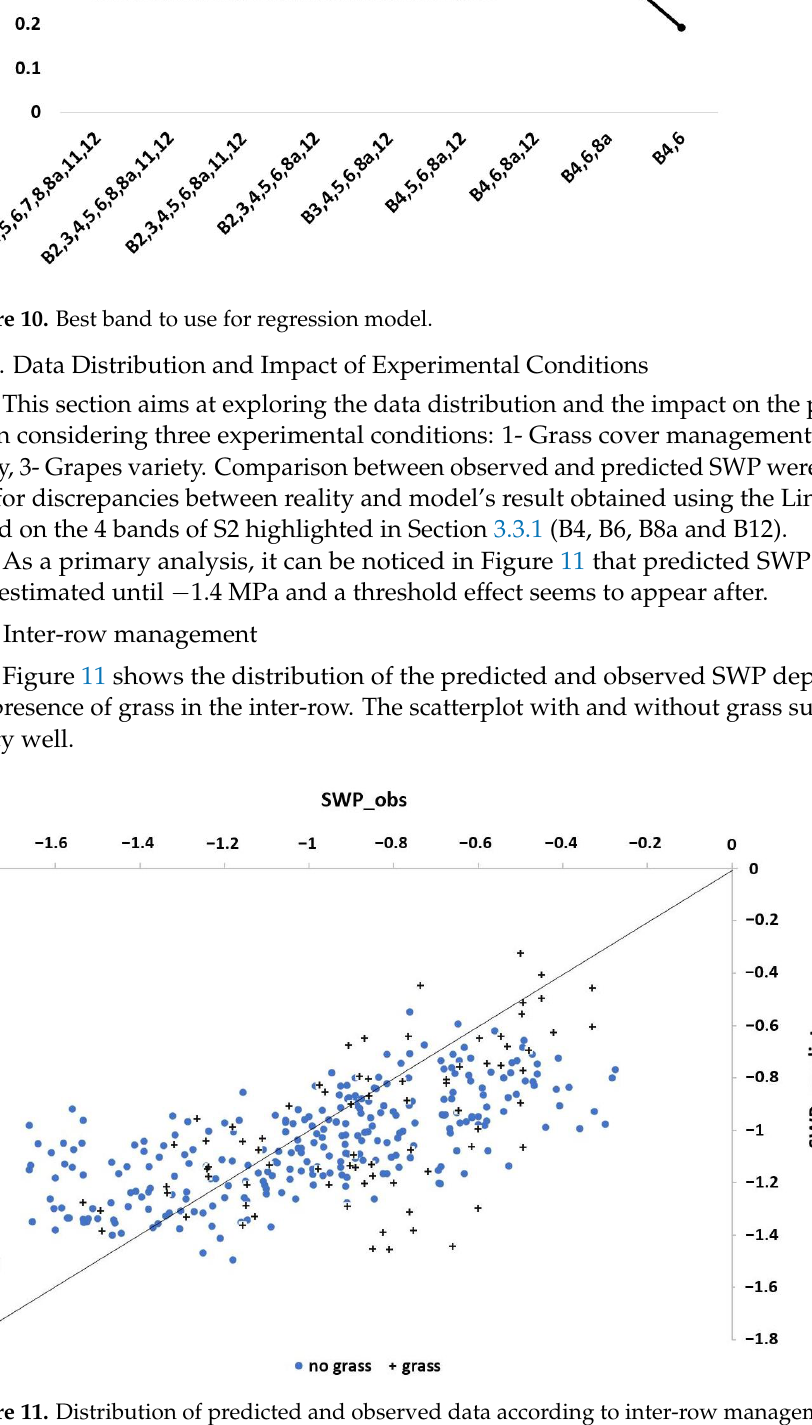
Figure 11. Distribution of predicted and observed data according to inter-row